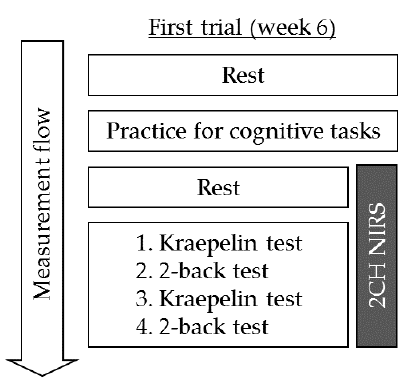
Figure 1. Measurement of regional cerebral blood flow. Regional cerebral blood flow (rCBF) dur- ing the Kraepelin and 2-back tasks was measured using two-channel near-infrared spectroscopy.